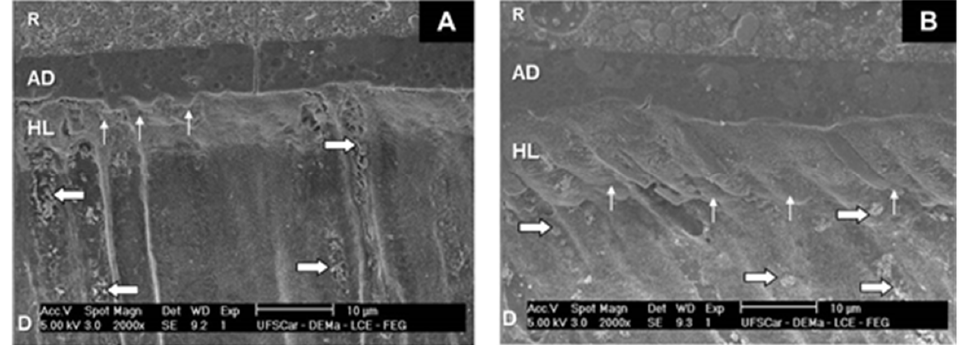
Figure 2. SEM micrographs of Group 2. ( A ) 2000×. Note the hybrid layer (HL) at the dentin (D)/adhesive (AD)/composite resin (R) interface, with resinous tags (thin arrows), and biosilicate microparticles (thick arrows). ( B ) 2000×. Hybrid layer (HL) at the dentin (D)/adhesive (AD)/composite resin (R) interface; thin arrows: resinous tags; thick arrows: biosilicate microparticles.